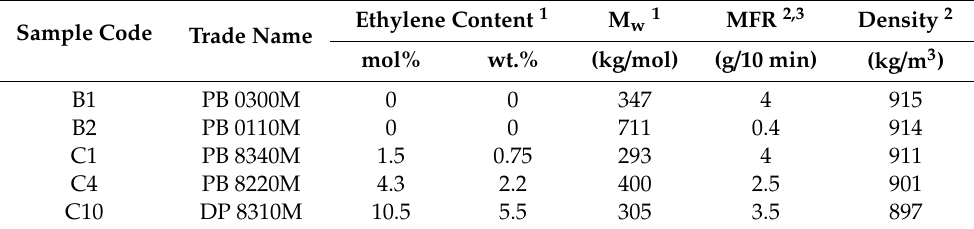
Table 1. List of isotactic random butene-1 / ethylene copolymers used in this work, including their